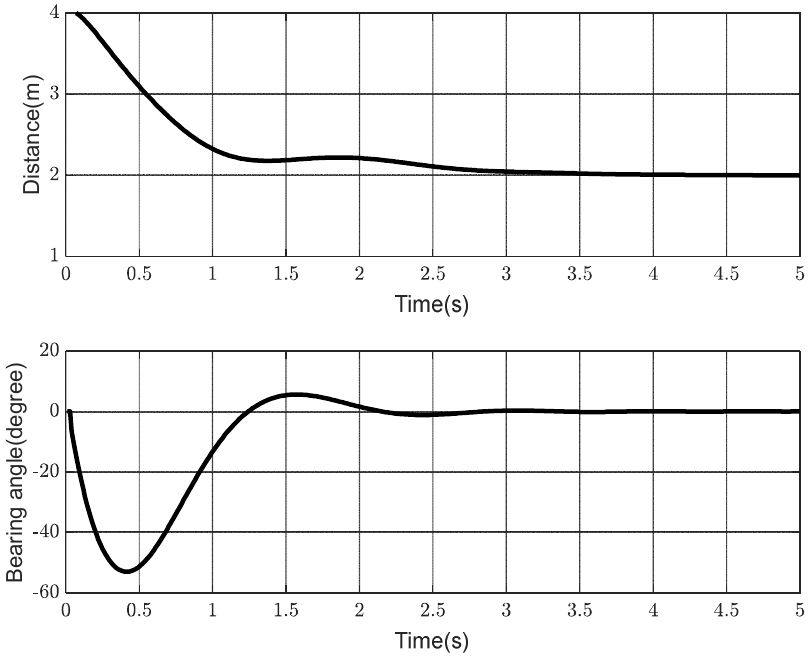
Figure 12. PID model formation distance and bearing angle variation (desired following position (cid:0) (cid:1) 2 m ,0 ◦ (2, 0 ) ).